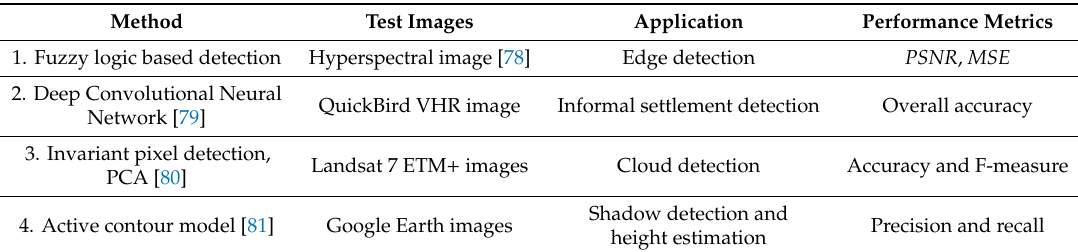
Table 6. Feature Detection methods and their performance